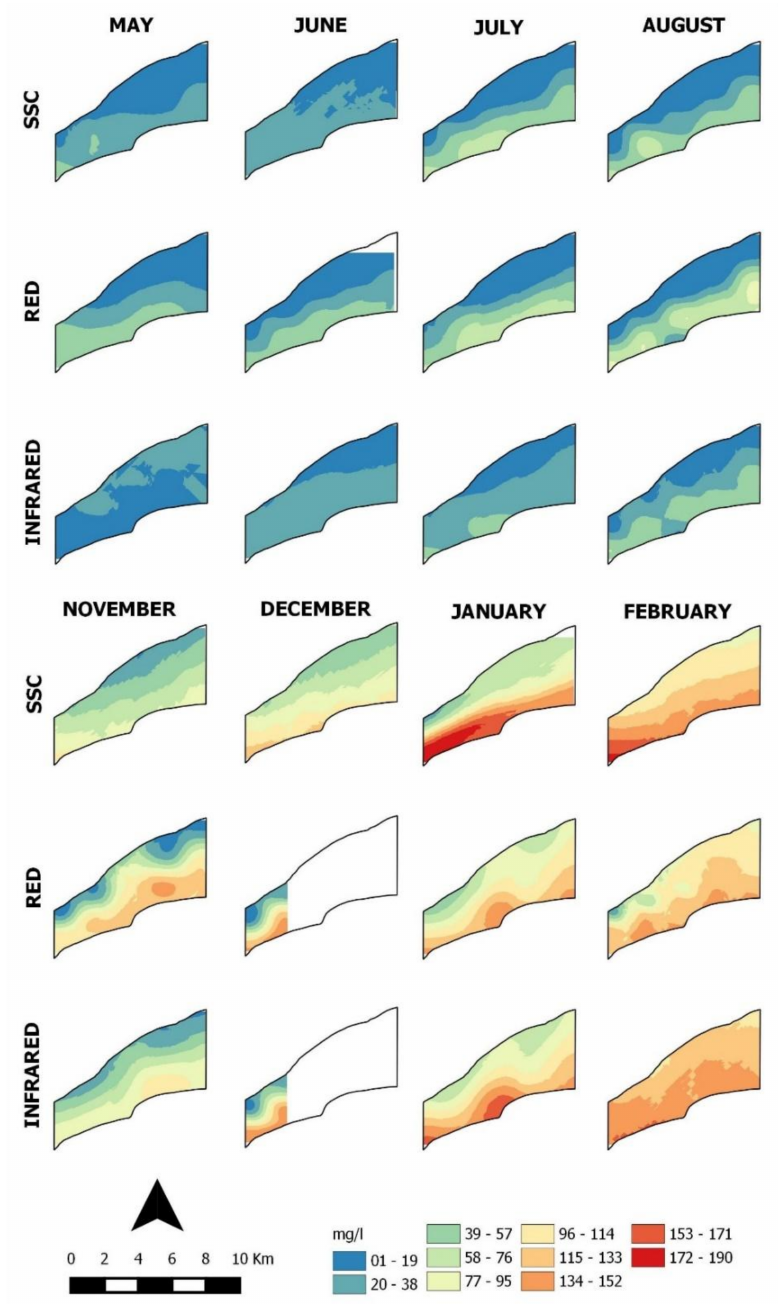
Figure 4. Interpolate SSC values from samples and red and infrared bands of MODIS